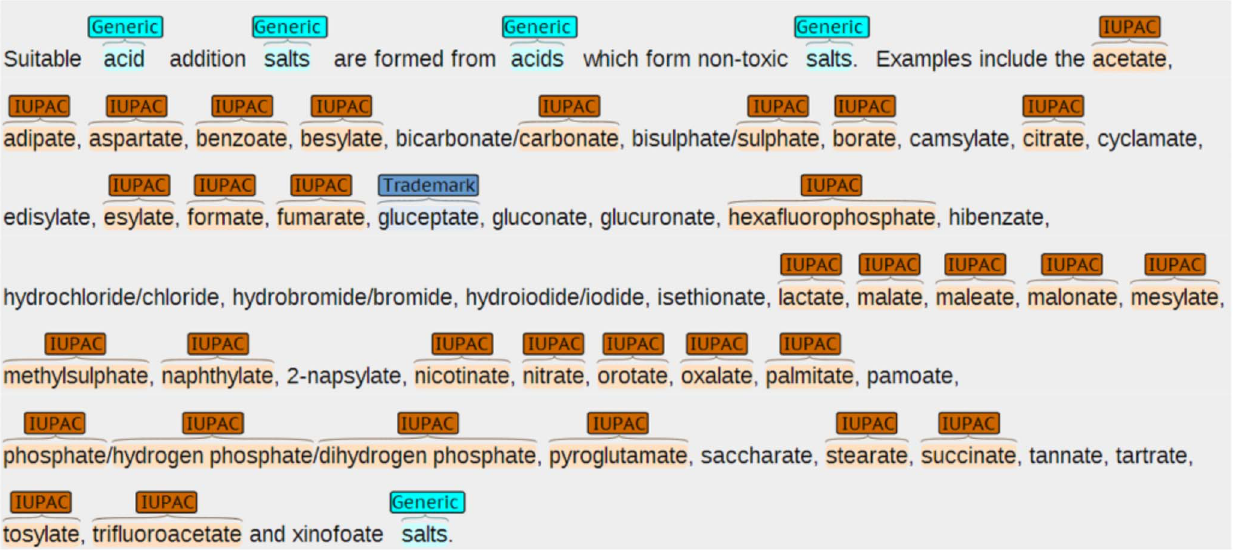
Figure 1. Example patent text with pre-annotations as shown by the Brat annotation tool. doi:10.1371/journal.pone.0107477.g001 PLOS ONE |